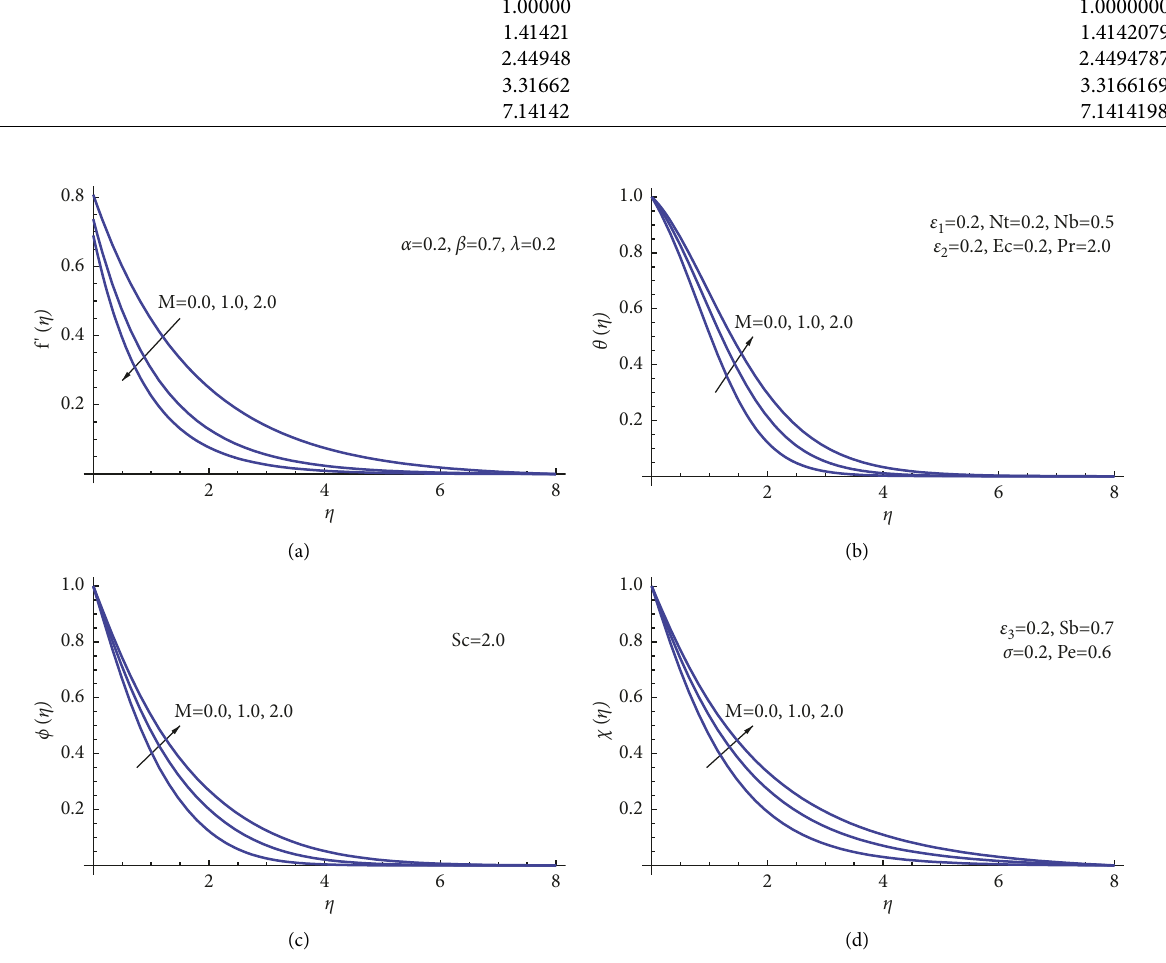
Figure 2: (a) Impact of M on f ′ ( η ) . (b) Impact of M on θ ( η ) . (c) Impact of M on ϕ ( η ) . (d) Impact of M on χ ( η )